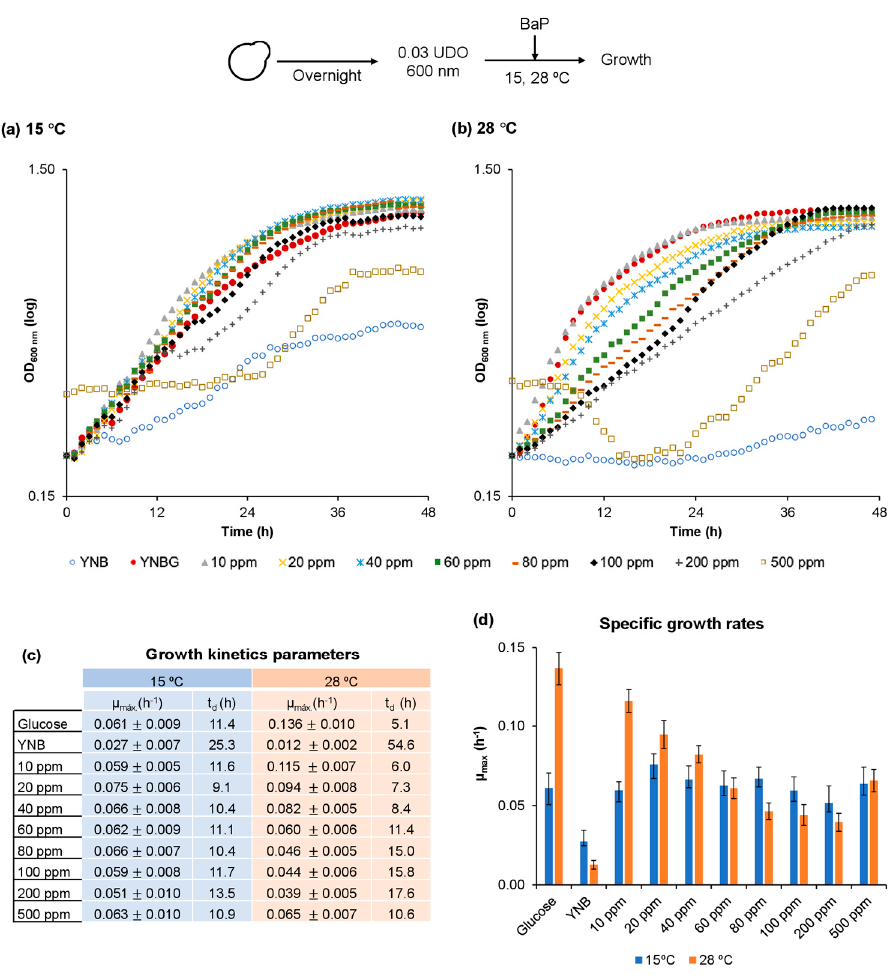
Figure 4. The effect of benzo(a)pyrene and temperature on D. hansenii growth. The effect of different BaP concentrations on D. hansenii growth was studied at two different temperatures: ( a ) 15 °C, ( b ) 28 °C to obtain ( c ) growth kinetics parameters, and ( d ) specific growth rates at different BaP concentrations and temperatures. The curves depict a representative result of three experimental replicates, each one performed by triplicate. The data in ( c , d ) represent the average values ± SD (standard deviation) of the nine results obtained from the curves.